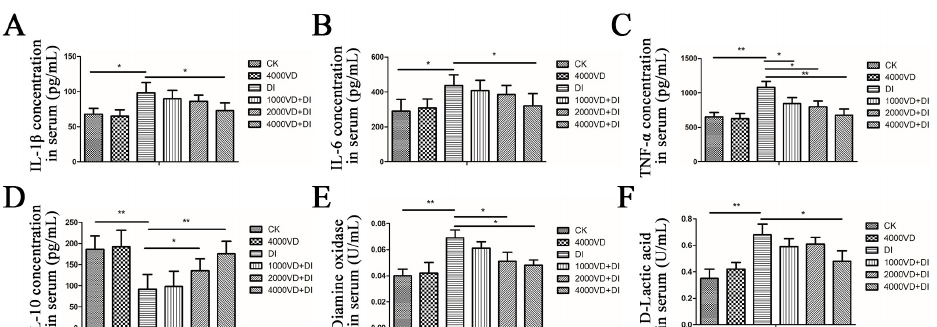
Figure 2. Effects of different supplement levels of VD 3 on serum intestinal injury markers and inflammatory cytokines in the Wenchang chicken oxidative stress model. ( A ) The IL-1 β concentration of each group, ( B ) IL-6 concentration of each group, ( C ) TNF- α concentration of each group, ( D ) IL-10 concentration of each group, ( E ) DAO activity in the serum of each group, ( F ) D-LA content in the serum of each group. (Statistical analysis of the data was performed using the Duncan method to analyze the significance of differences between samples by IBM SPSS software, * p < 0.05, ** p < 0.01).